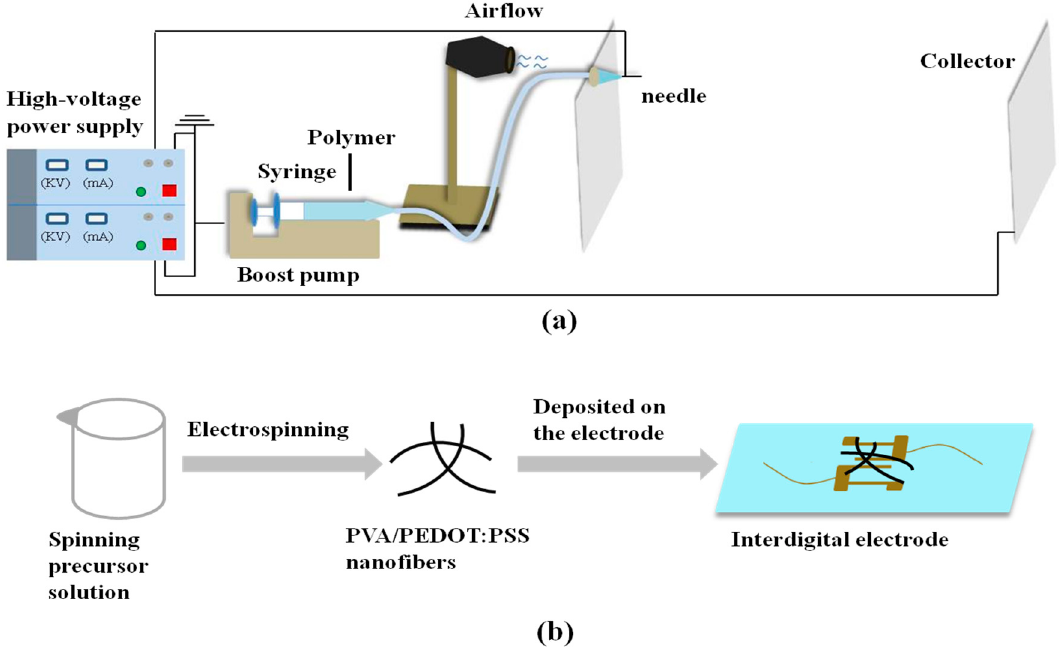
Figure 1. ( a ) Schematic diagram of the experimental device. High voltage between the spinneret and the collector can be increased to 70 kV. The needle and syringe were connected by an extension tube. The distance between the needle and collector was 120 cm; ( b ) schematic illustration of a sensor based on the composite fibers for electrical and gas sensing measurements.